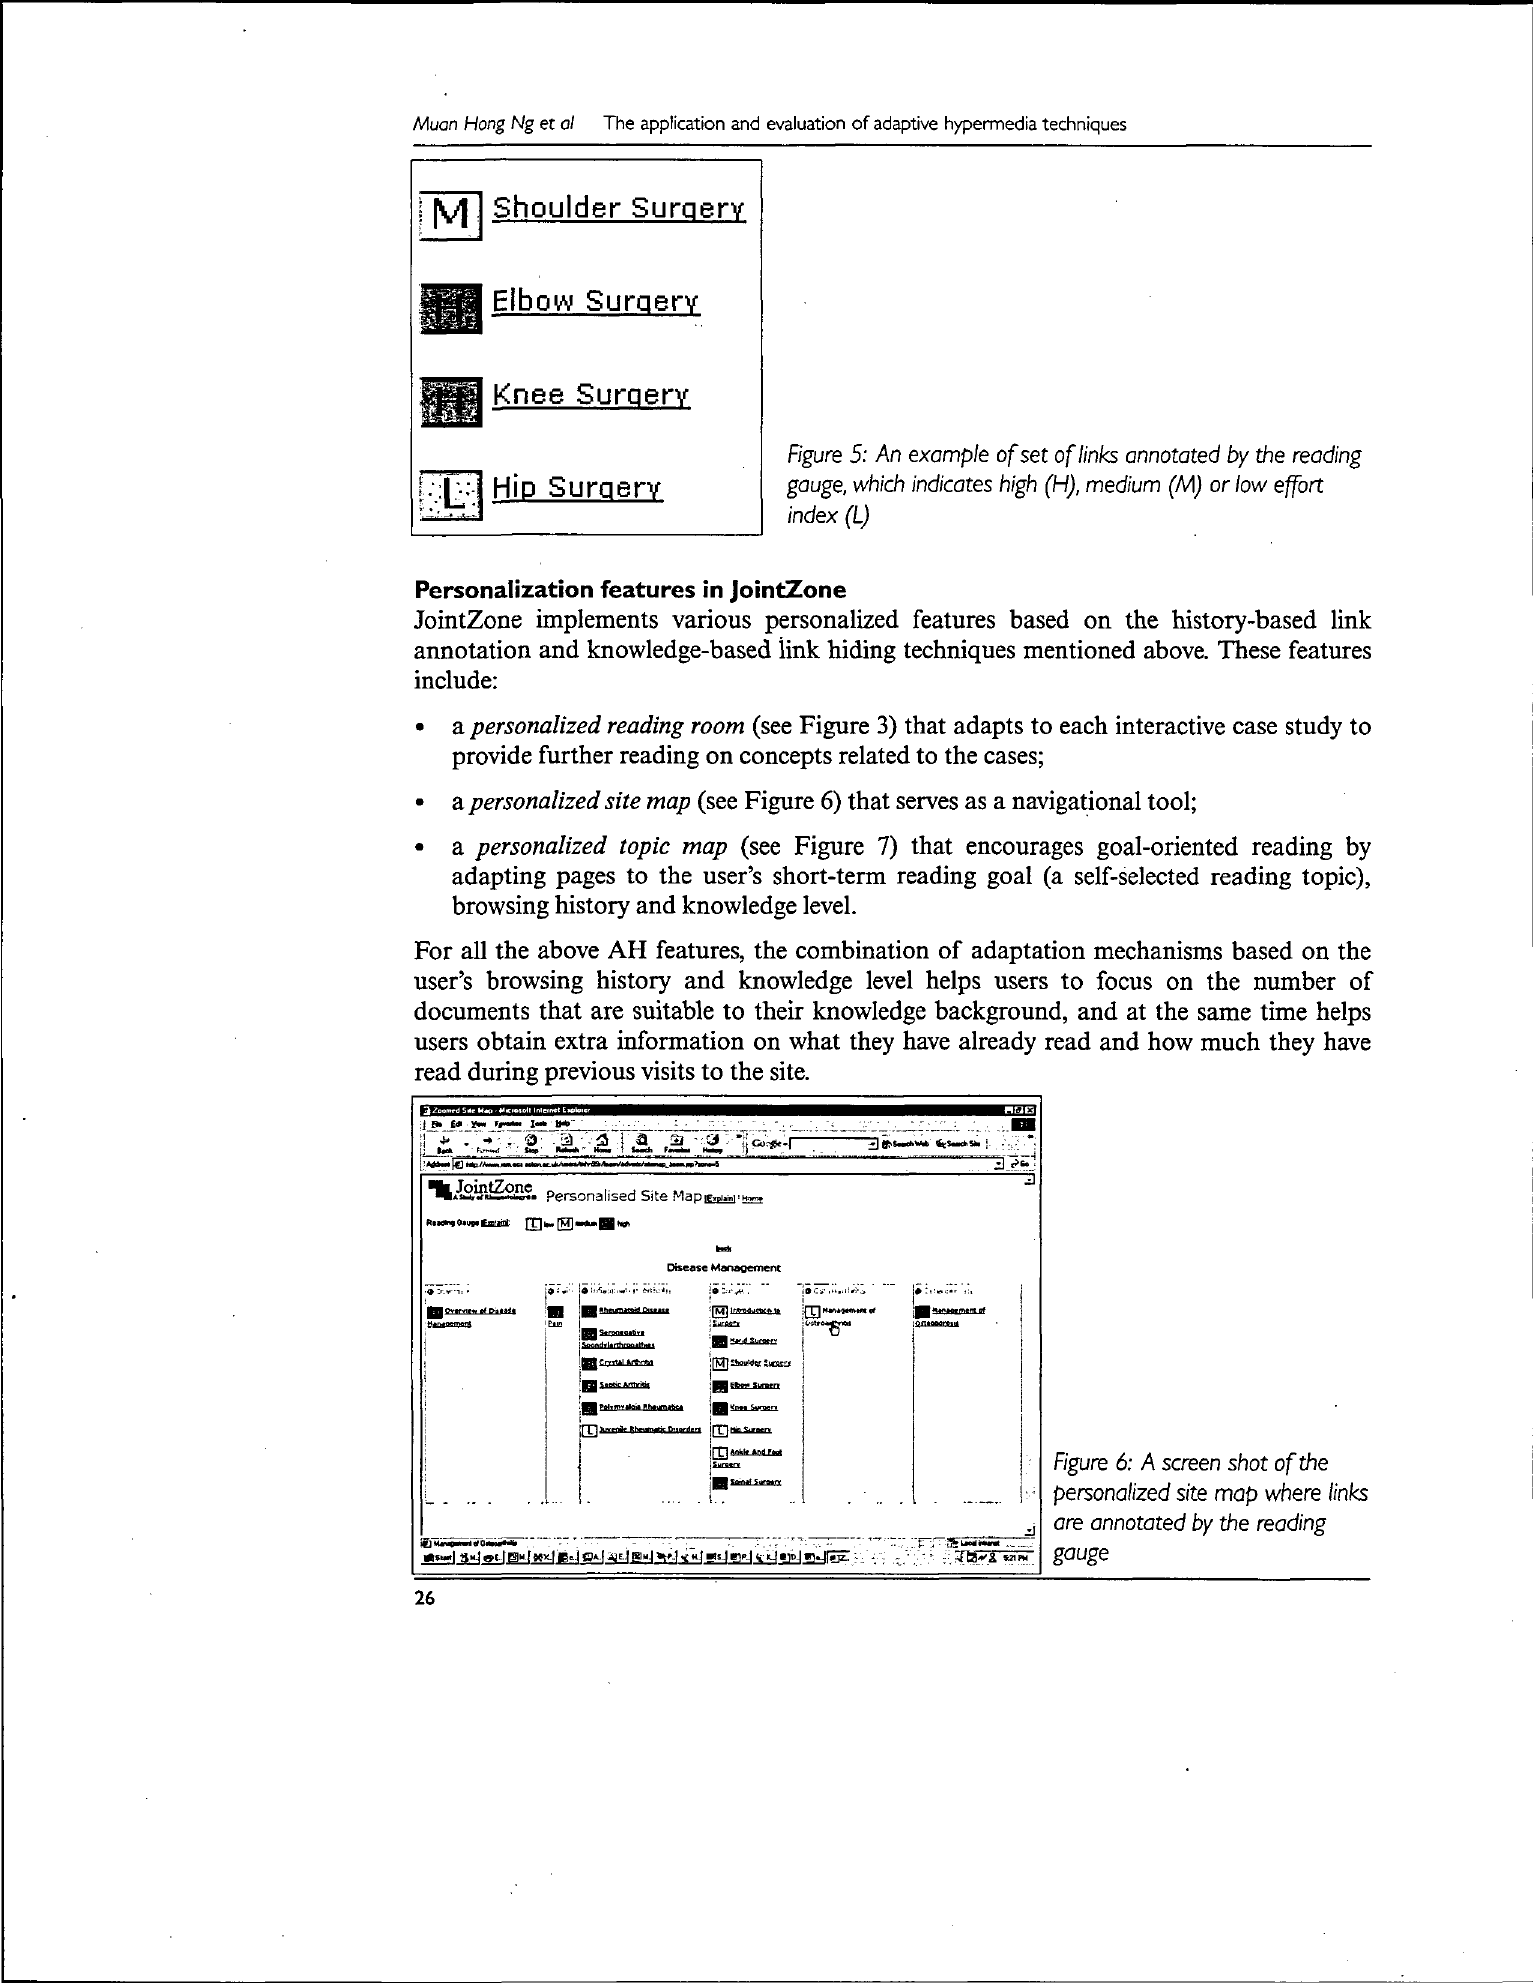
Figure 5: An example of set of links annotated by the reading gauge, which indicates high (H), medium (M) or low effort index (L)